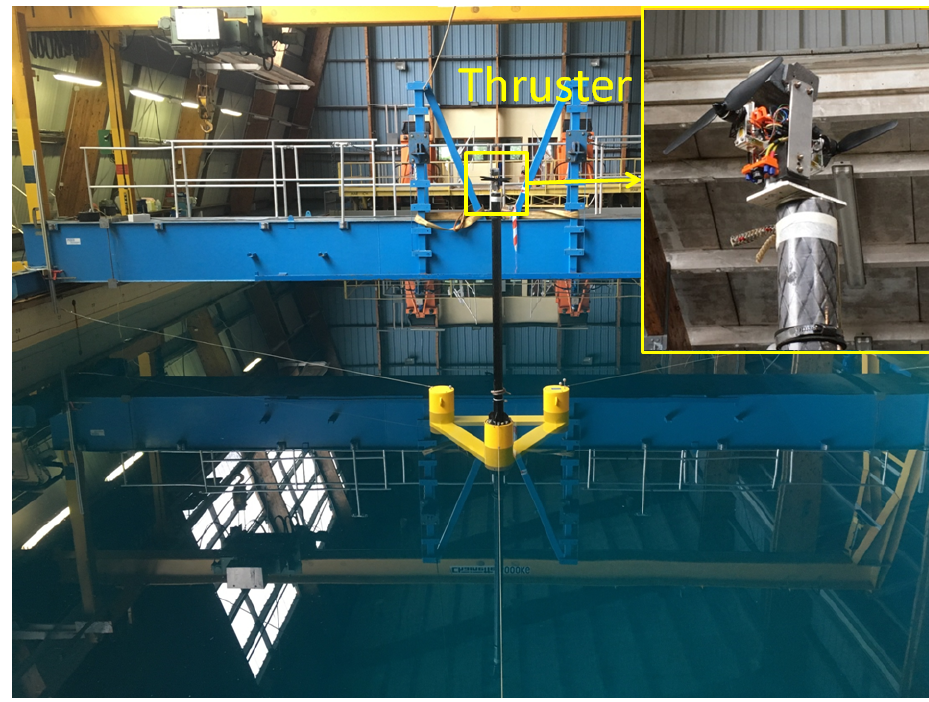
Figure 1. Model in the basin of Ifremer with the thruster.